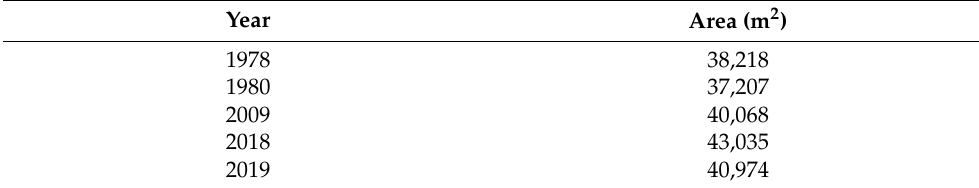
Table 4. Gross areal measurements of the vegetated island